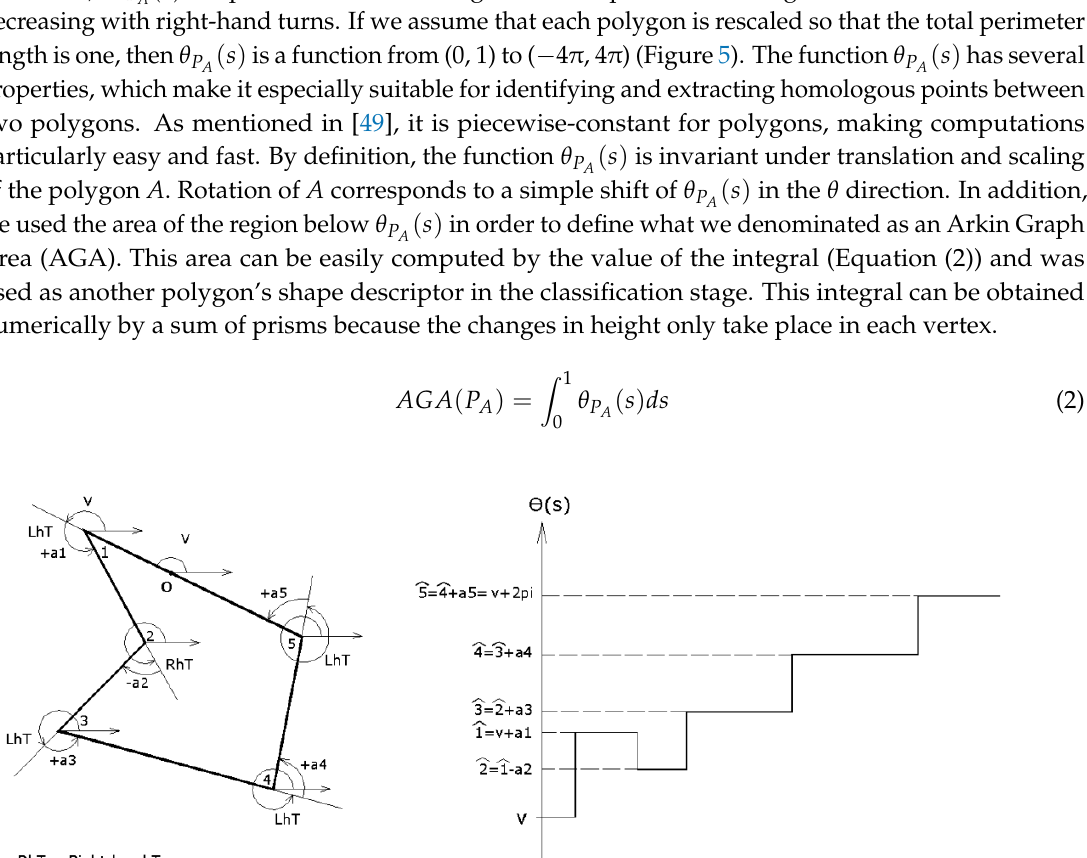
Figure 5. Defining the turning function θ P